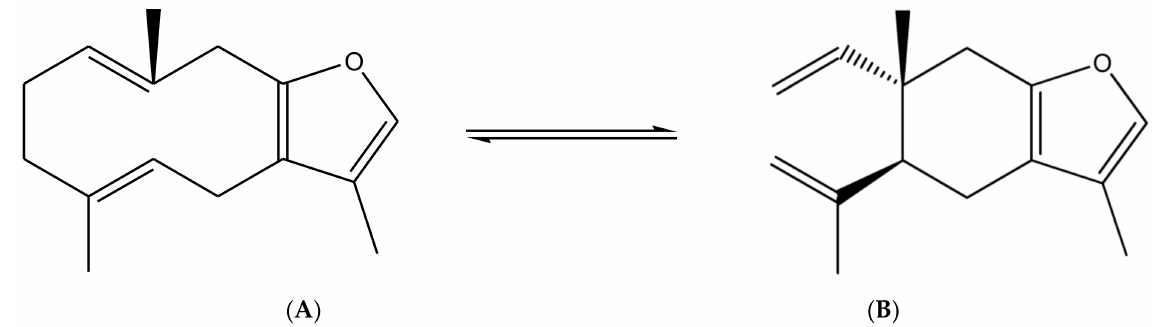
Figure 1. Cope rearrangement of furanodiene ( A ) to curzurene ( B